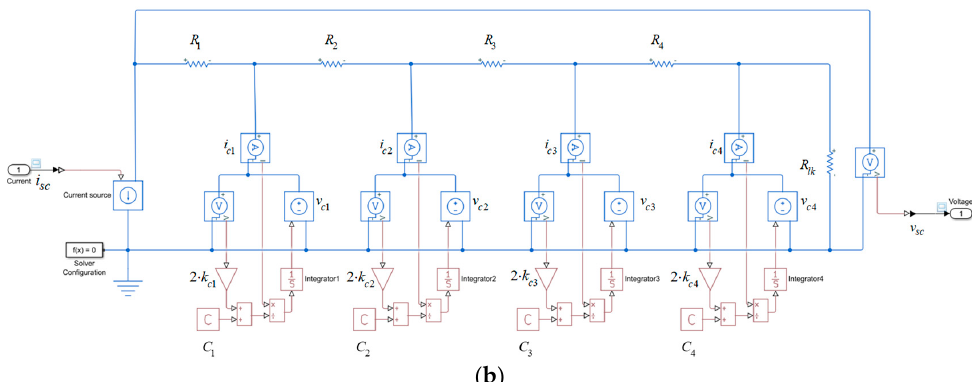
Figure 5. Series model: ( a ) Electric circuit; ( b ) Simscape implementation.